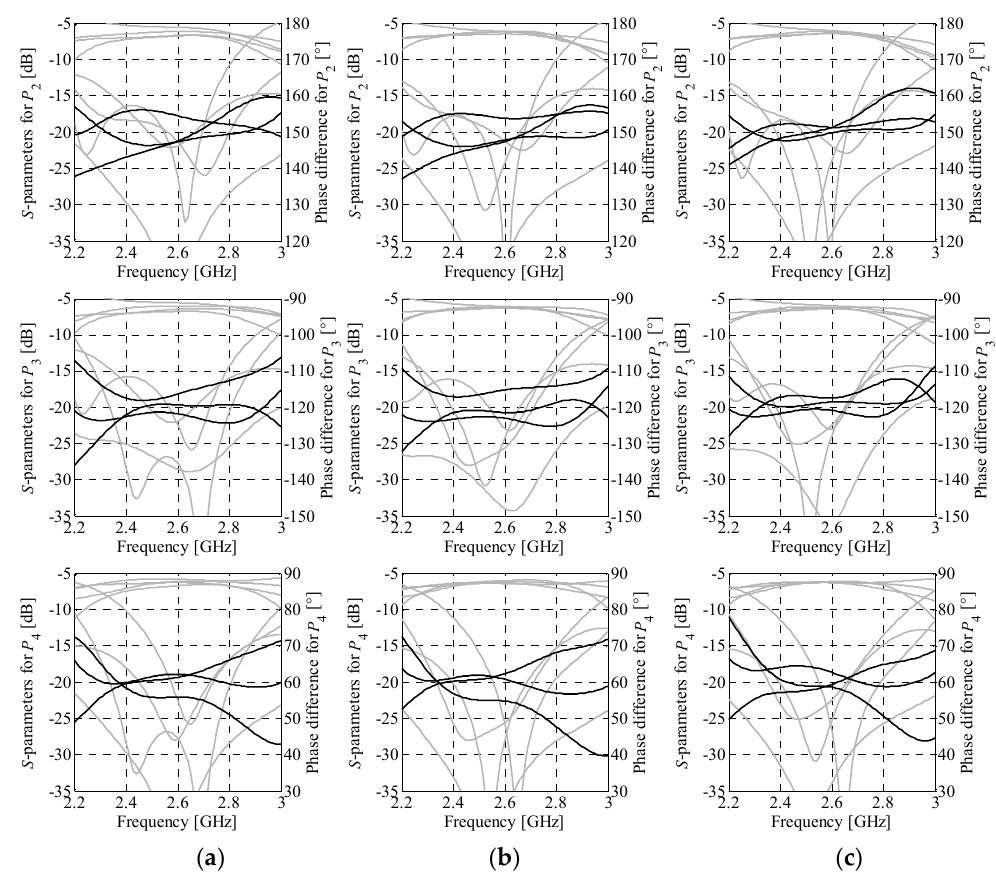
Figure 10. Butler matrix 1: structure characteristics at different stages of the design process. The responses are obtained from evaluations of the composite model R Be at ( a ) the initial design z (0) , ( b ) the final design z * (used as a starting point for fine-tuning), and ( c ) the optimized design y * found based on simulations of the assembled BM model R Be . Each row shows responses of the structure “seen” from different input port ( P 1 ... 4 ). Gray and black lines represent magnitude and phase responses, respectively.